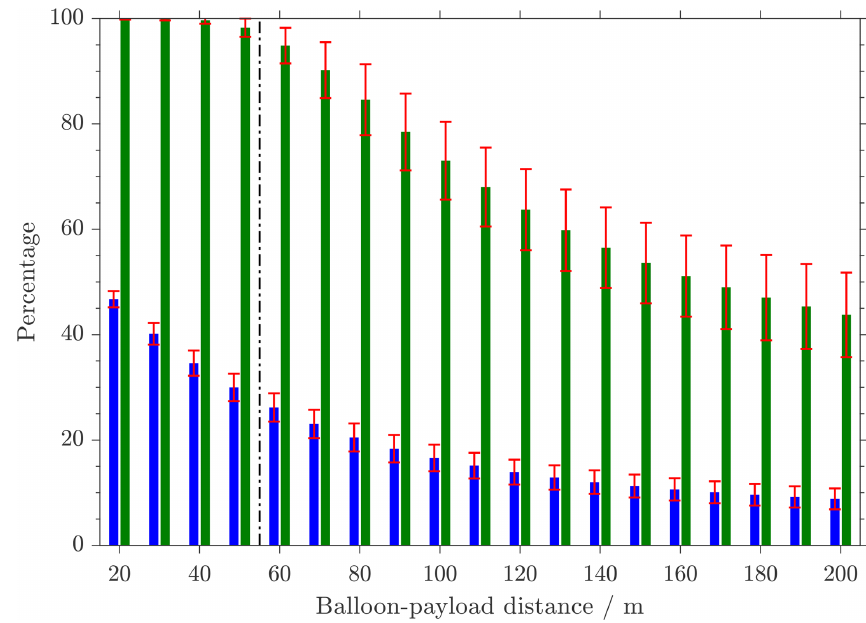
Figure 5. Blue shows the mean probability of wake encounter using background information from 30 radiosonde flights. Green shows the percentage of potentially wake-affected altitude bins ( P wake > 5%). Red shows the standard deviation between different launches. Black shows the payload–balloon distance of a standard radiosonde.